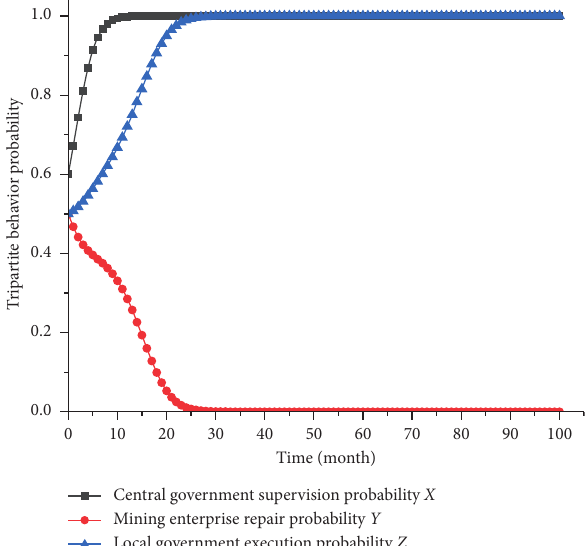
Figure 4: Impact of remediation costs on strategic choices of mining